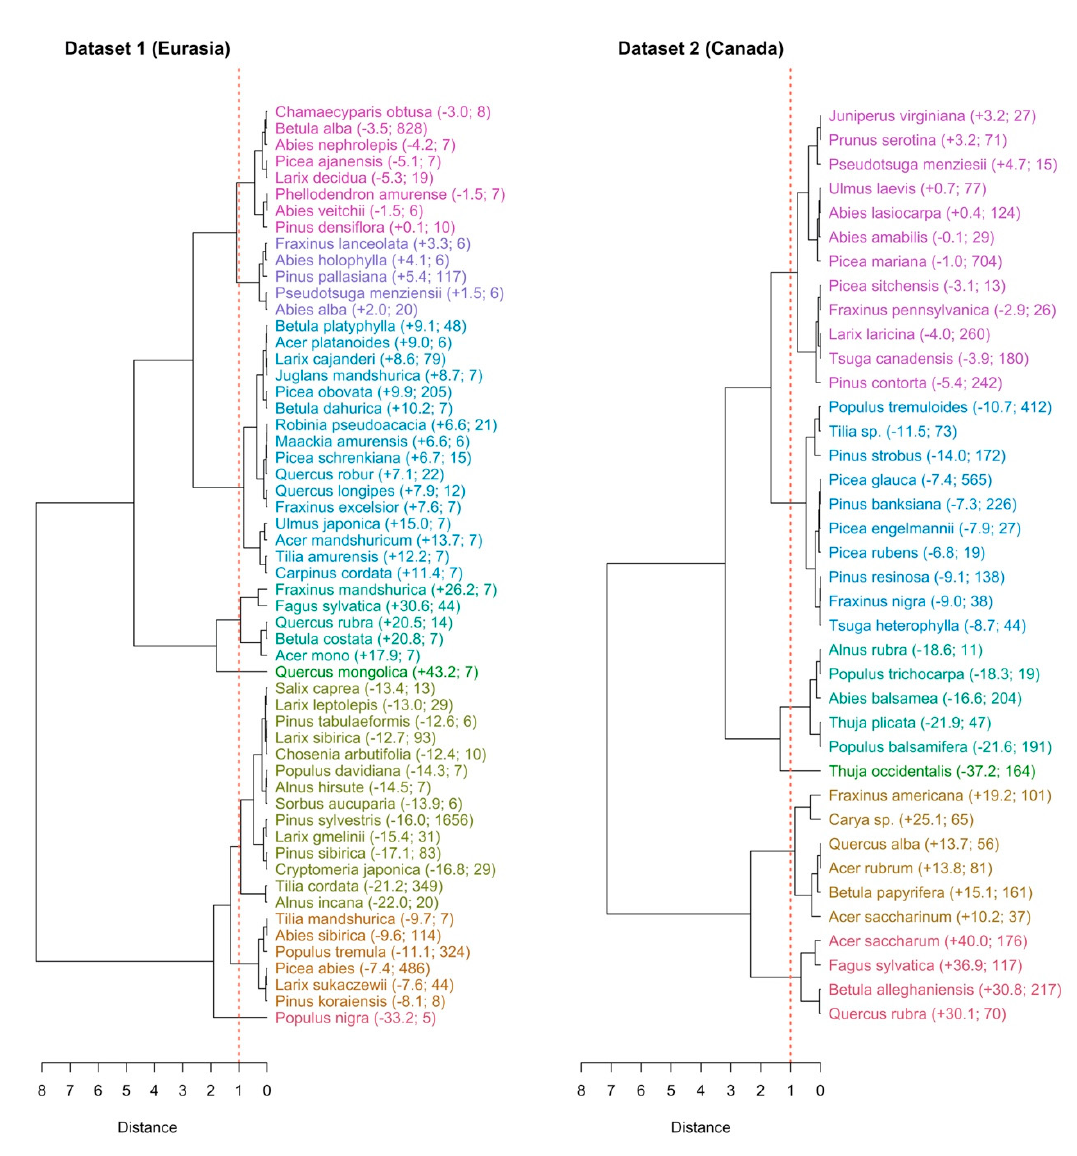
Figure 4. The dendrograms showing the grouping of species by their allometry, for Dataset 1 and Dataset 2. Note: (1) The γ k values (Equation (4)) are presented in parenthesis for each species ( γ k was centred to zero by subtracting the mean µ from each γ k value) and the sample size for each species. (2) In di ff erent colours are the species that were grouped by cutting the dendrogram at a distance of 1.0 (vertical dashed red line).